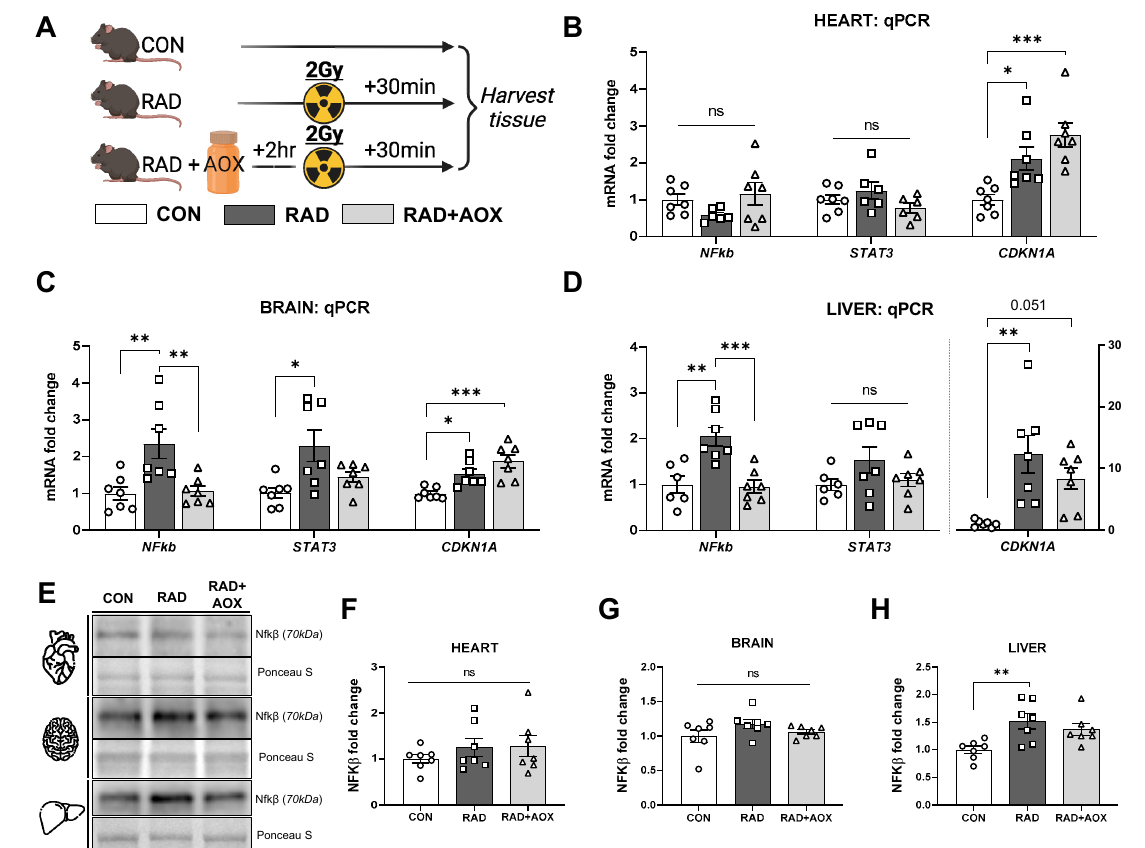
Figure 2. Antioxidant multi-ingredient supplement attenuates increase in NF-k β induced by ionizing radiation. ( A ) Design of experiment. Mice were harvested 24 h following 2 Gy radiation. 2 h prior to IR exposure, mice were gavage with vehicle placebo (RAD) or antioxidant (RAD + AOX). Control mice (CON) were not gavage fed or irradiated. The mRNA abundance of; NF-k β , STAT3 , and CDKN1A in the ( B ) heart, ( C ) brain, and ( D ) liver were measured using qRT-PCR. Analysis was done using the 2 − ∆ method normalized to B2M housekeeper gene. ( E ) Representative Western blot images for NFk β protein expression and densitometric quantification in the ( F ) heart, ( G ) brain and ( H ) liver. Data is expressed as fold change mean ( ± SEM) relative to CON. Individual data points shown, n = 7 per group. Statistical analysis was done with One-way ANOVA with Tukey’s post hoc . *, **, and *** denote a significant difference between groups of p < 0.05, p < 0.01, and p < 0.001, re- spectively.